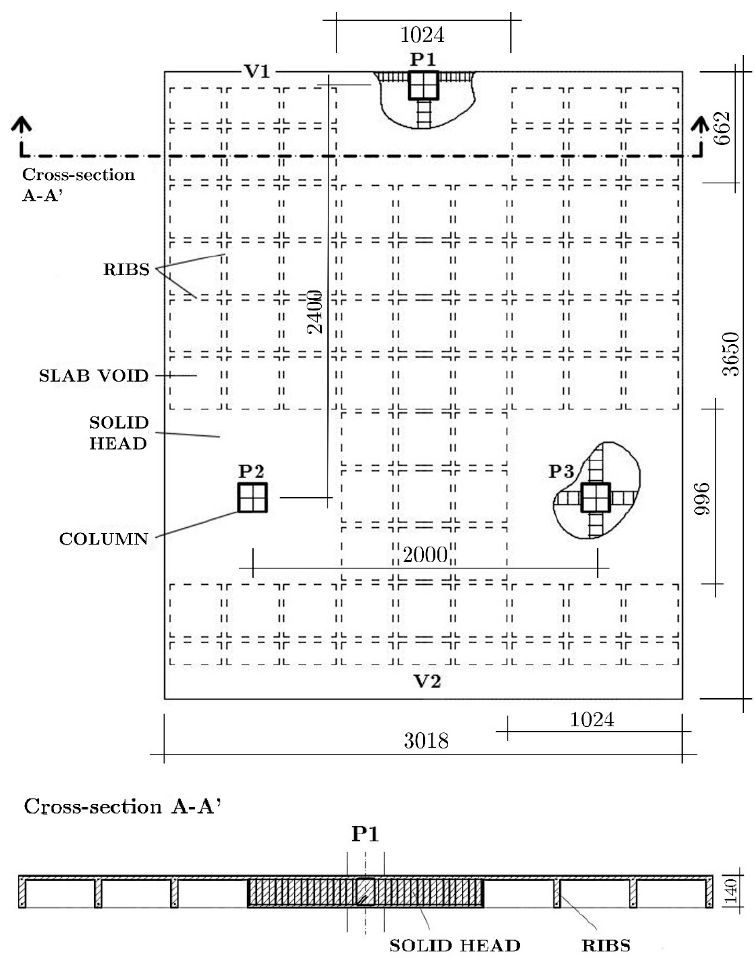
Figure 1. Floor plan and waffle plate section of BS1 and BS2 specimens. Dimensions in mm. 108